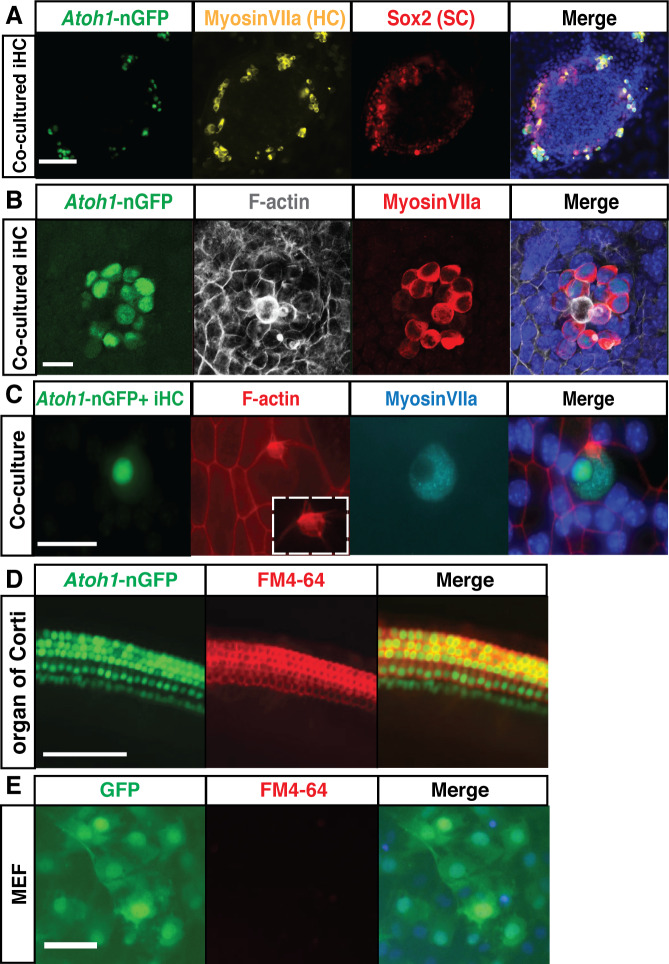
Induced hair cells demonstrate functional properties reminiscent of primary hair cells.(A) iHCs (Atoh1-nGFP+/MyosinVIIa+) co-cultured with dissociated primary E13.5 organs of Corti organize into epithelial islands alongside primary hair cells (Atoh1-nGFP-/MyosinVIIa+) and primary supporting cells (Sox2+). Merged image includes Hoechst nuclear stain. Scale bar represents 100 um. (B) iHCs co-cultured with dissociated primary E13.5 organs of Corti show F-actin polarization by Phalloidin labeling (grey) and express MyosinVIIa (red). Merged image includes Hoechst nuclear stain. Scale bar represents 20 um. (C) iHCs co-cultured with dissociated primary E13.5 organs of Corti show F-actin rich projections by Phalloidin labeling (red) and express MyosinVIIa (cyan). Scale bar represents 20 um. (D) Organ of Corti explants from Atoh1-nGFP transgenic mice accumulate the styryl dye FM4-64 specifically in the hair cells. Image taken after 30 s of incubation with FM4-64. Merged image includes Hoechst nuclear stain. Scale bar represents 100 um. (E) MEFs infected with eGFP control virus do not accumulate the styryl dye FM4-64. Image taken after 30 s of incubation with FM4-64. Merged image includes Hoechst nuclear stain. Scale bar represents 50 um.